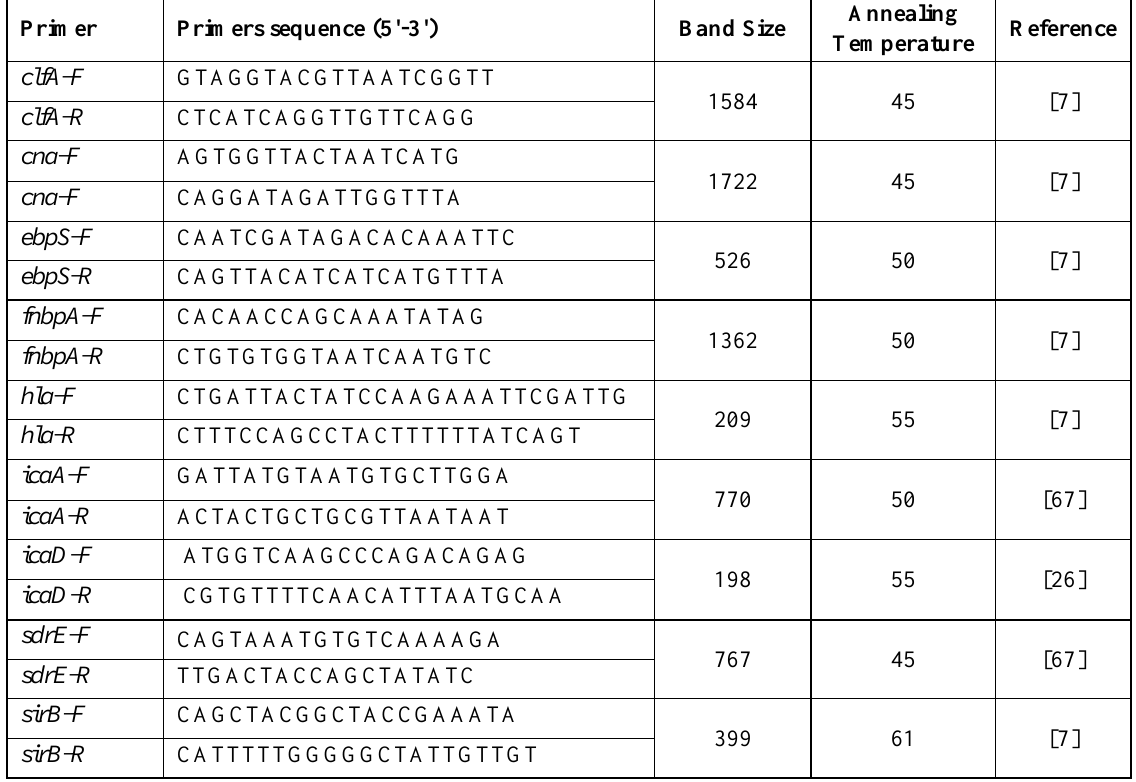
Table 1. Primers used and the annealing temperatures for the amplified genes. Primer